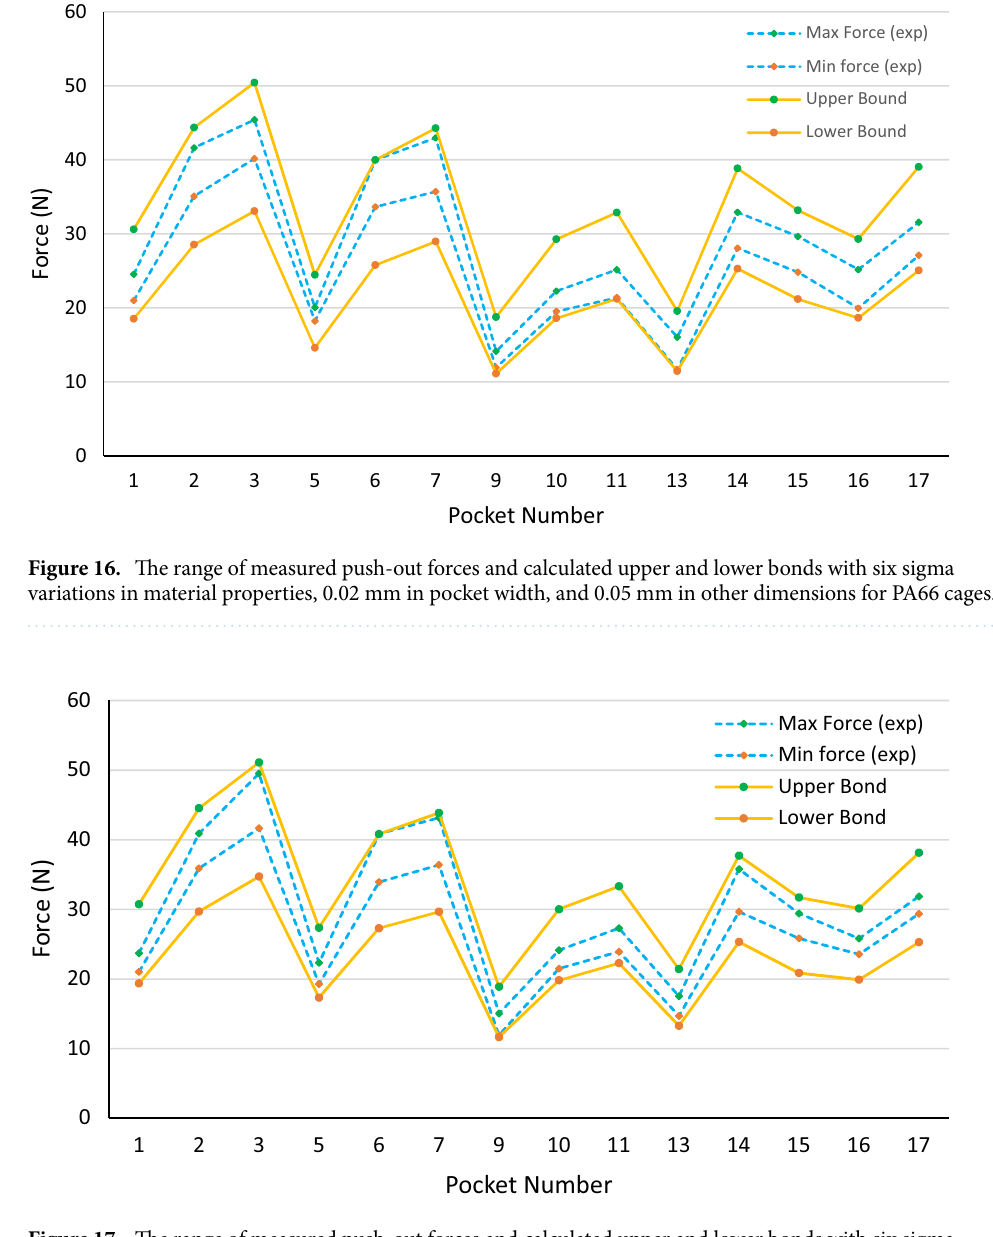
Figure 17. The range of measured push-out forces and calculated upper and lower bonds with six sigma variations in material properties, 0.02 mm in pocket width, and 0.05 mm in other dimensions for PPA